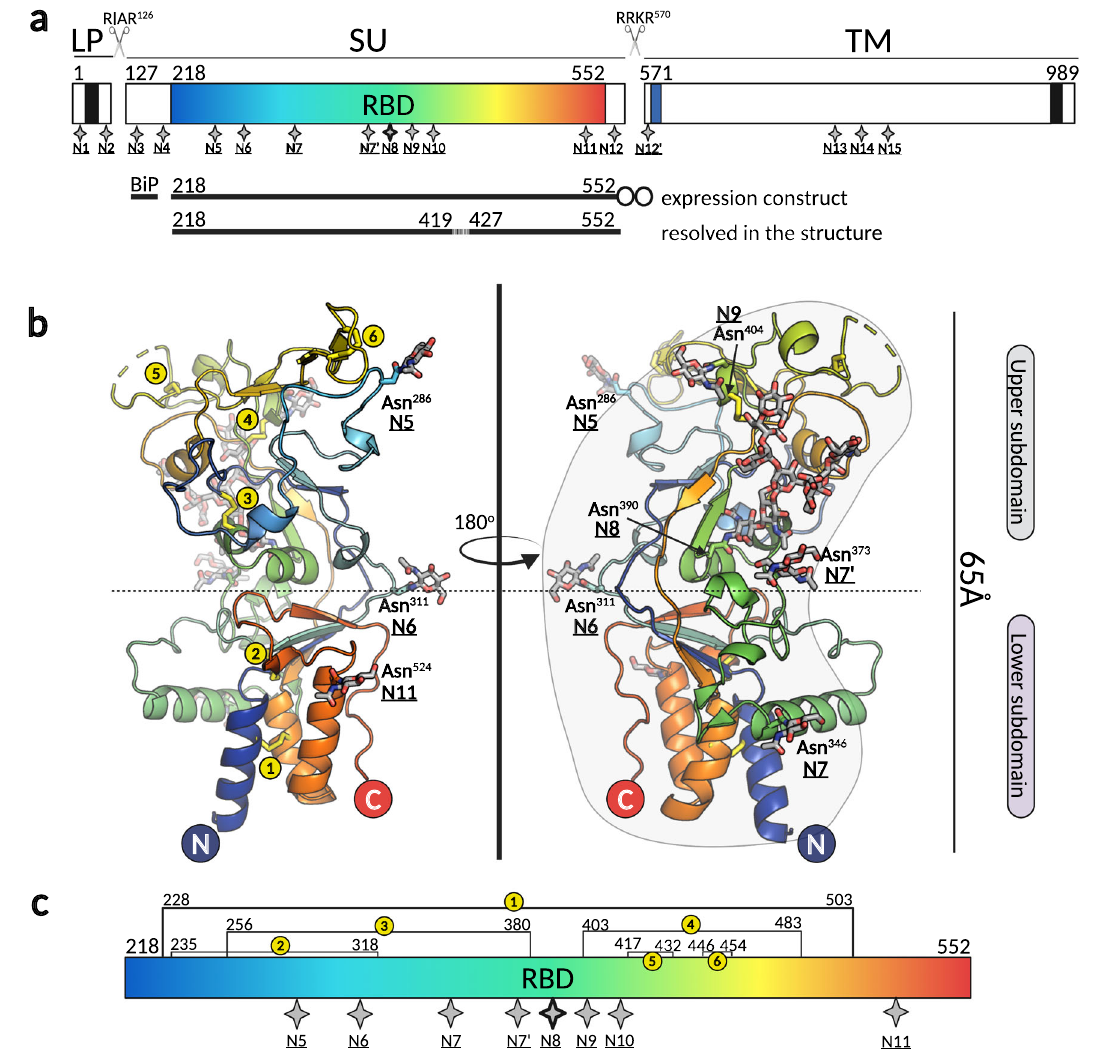
Fig. 1 | Overview of the novel fold adopted by the SFV RBD. a Schematic representation of SFV Env protein organization indicating the three constituent chains:leaderpeptide(LP),surfacesubunit(SU),andtransmembranesubunit(TM). The transmembrane domains anchoring the LP and TM in the membrane are represented as black boxes; the receptor-binding domain (RBD) within SU is highlightedinblue-redspectrum;thefusionpeptideattheN-terminusoftheTMis shown in blue. The furin sites between the LP and SU (RIAR 126 ), and SU and TM (RRKR 570 ) are indicated with scissors icons. The RBD expression construct con- tained the exogenous BiP signal at the N-terminus, residues 218 to 552 of the SFV gorilla GII Env and a doublestrep tag at the C-terminus (shown astwo circles).The region comprising residues 420 – 426 is drawn as a dashed line because it was not seen in the electron density map. The 17 putative N-glycosylation sites for gorilla